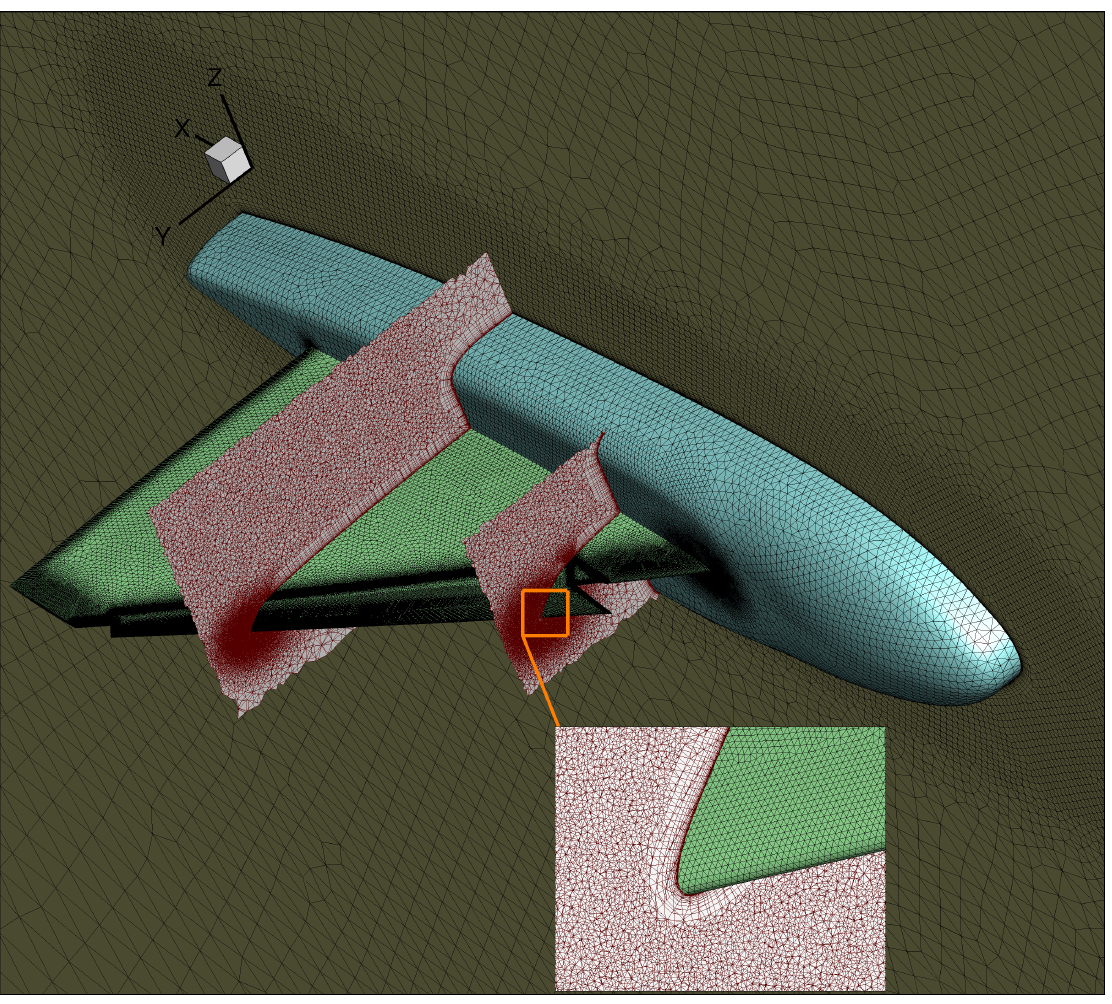
Figure 13. Visualization of the hybrid-unstructured grid of 8.9 million points for the